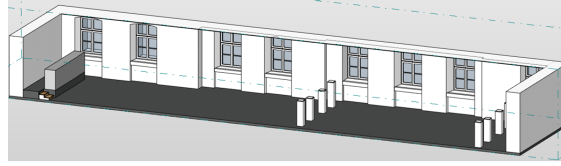
Figure 7. BIM compliant indoor model of the test